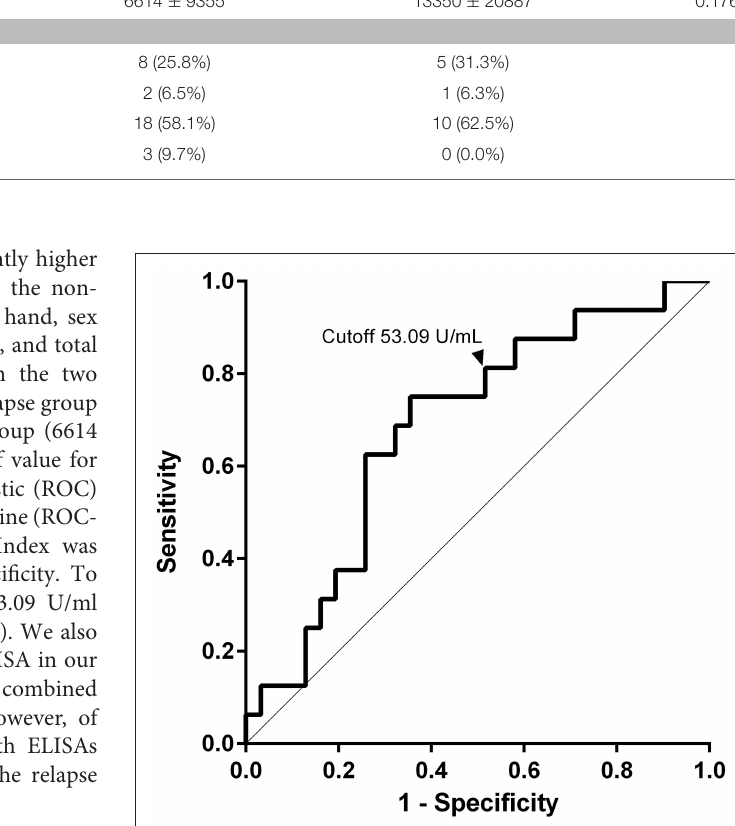
FIGURE 1 | Values of anti-BP180NC16A IgG at baseline for prediction of relapse. The ROC curve was used to evaluate the ability of BP180 ELISA index at baseline to predict relapse. The cutoff value was set at 53.09 U/ml with 81.3% sensitivity and 48.4%